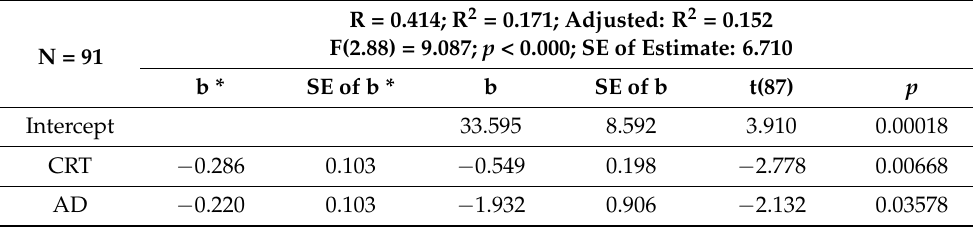
Table 4. Multiple regression—predictors of comprehensive game effectiveness. R = 0.414; R 2 = 0.171; Adjusted: R 2 = N = 91